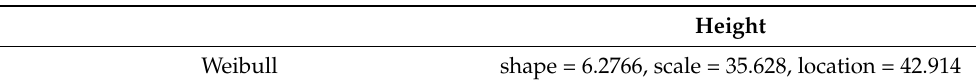
Table 6. MLEs of the model parameters for Height.